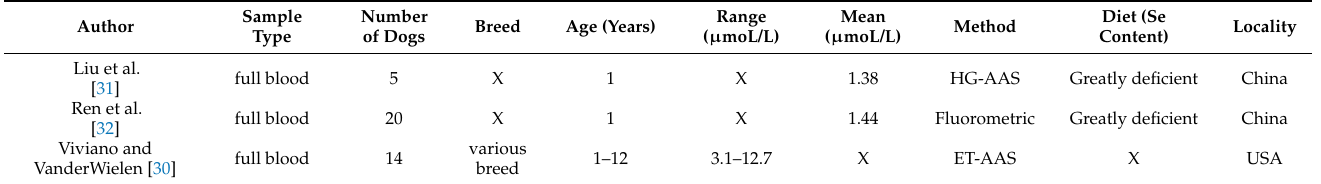
Table 2. Levels of selenium in serum and plasma measured by particular authors in their